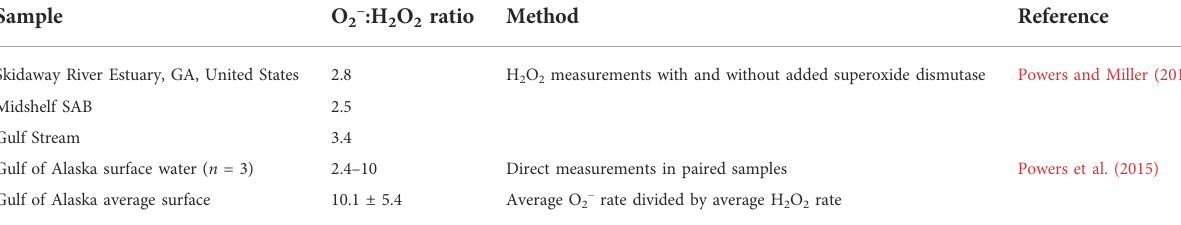
TABLE 6 Reported O 2 − and H 2 O 2 photoproduction ratios and additional ancillary